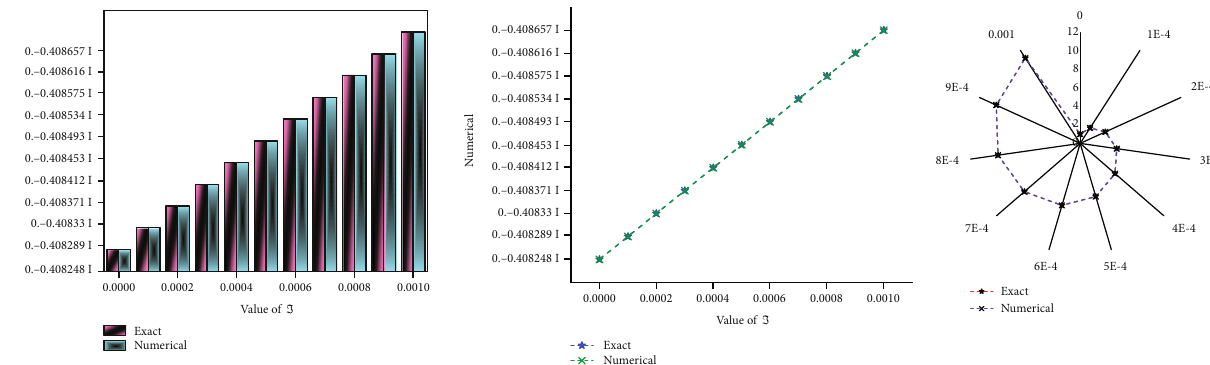
Figure 1: Exact, and numerical solutions based on the obtained analytical solution Equation (16) and septic B-spline scheme.